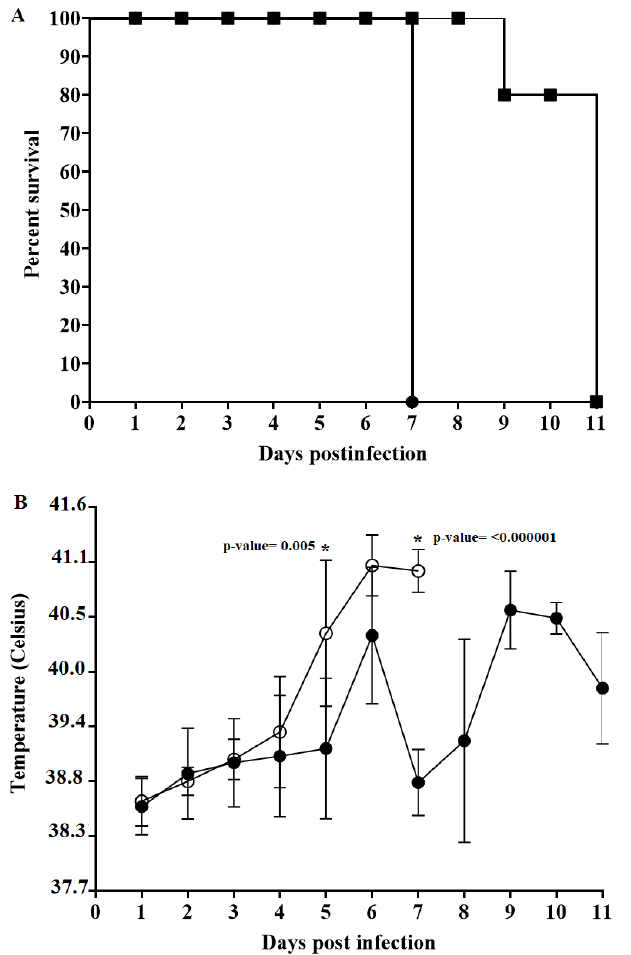
Figure 4. Evolution of mortality ( A ) and body temperature ( B ) in animals (five animals / group) IN infected with 10 5 TCID 50 of either E2 ∆ CCDC115v (filled symbols) or parental BICv (open symbols). Significant differences (*) in rectal temperatures between both groups of pigs infected with each virus at specific times post-infection were determined using the Holm–Sidak method ( α = 0.05) without assuming a consistent standard deviation. All calculations were conducted on the software GraphPad Prism version 8.